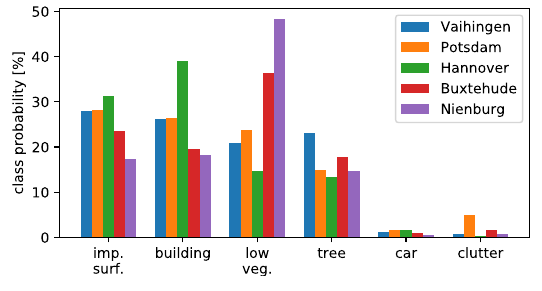
Figure 7. Class distribution of the datasets